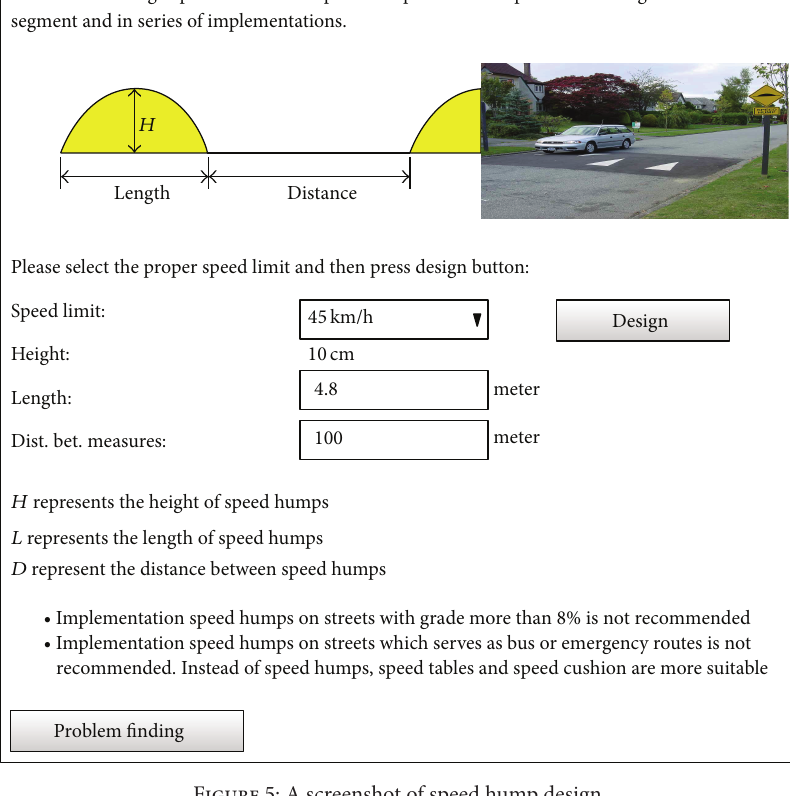
Figure 5: A screenshot of speed hump